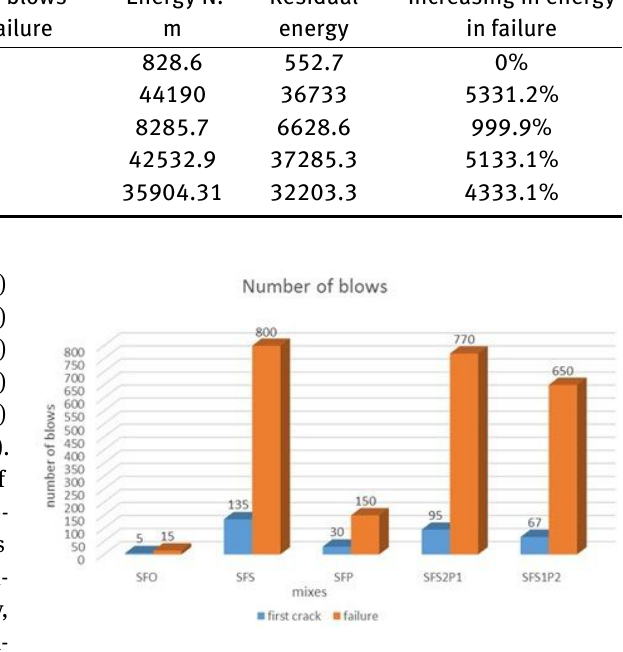
Figure 7: Number of blows caused first crack and failure